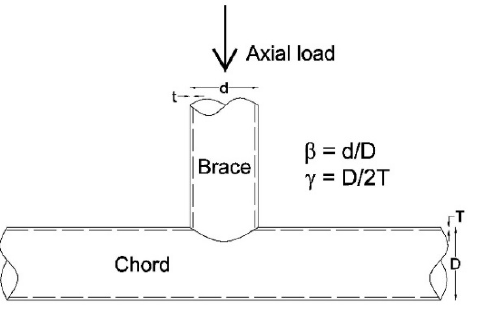
Figure 1. Schematic representation of tubular T-joints (circular hollow section (CHS)) [25].